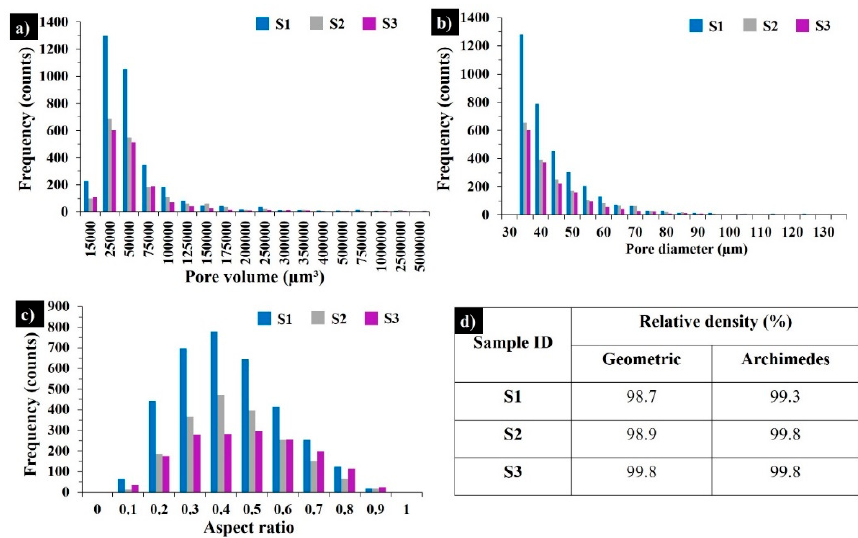
Figure 4. X-ray CT results in as-built samples S1, S2, and S3: pore size distributions ( a ), pore diameter distributions ( b ), aspect ratios of the pores ( c ), and relative geometric and Archimedes density results ( d ).